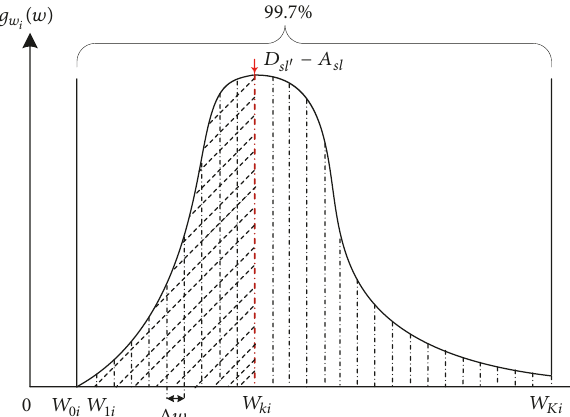
Figure 2: The distribution of transfer walking time.